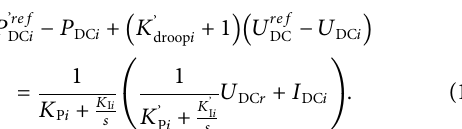
realizing the optimal allocation of unbalanced